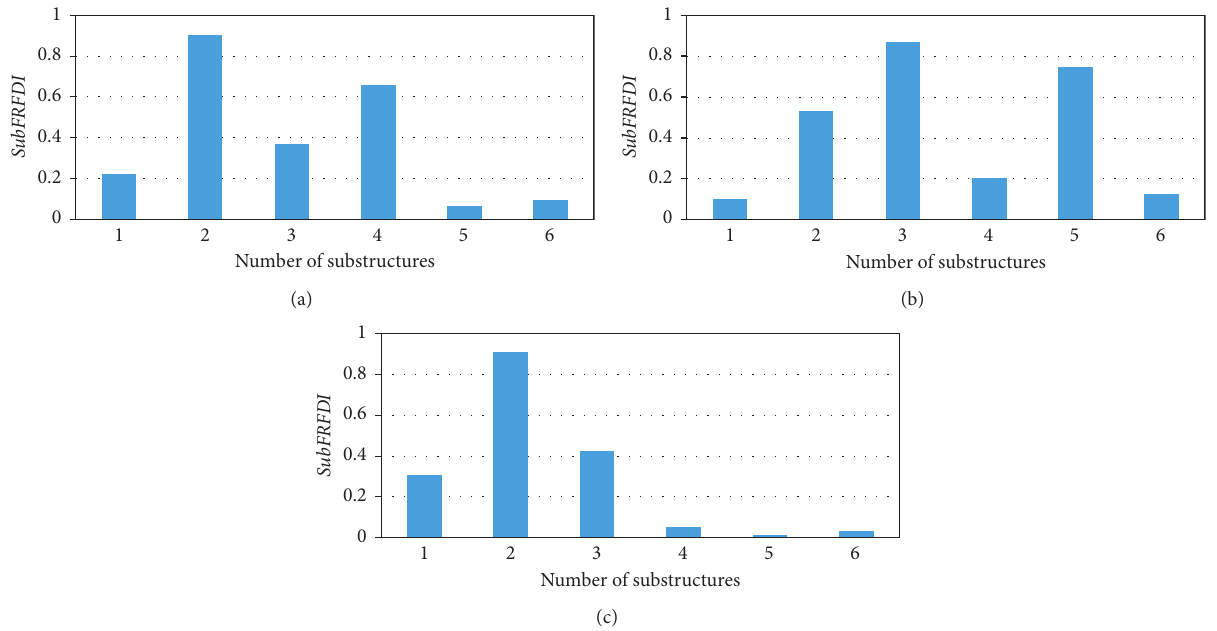
Figure 8: SubFRFDI values for (a) case Dam_2F&4F15%, (b) case Dam_3F&5F15%, and (c) case